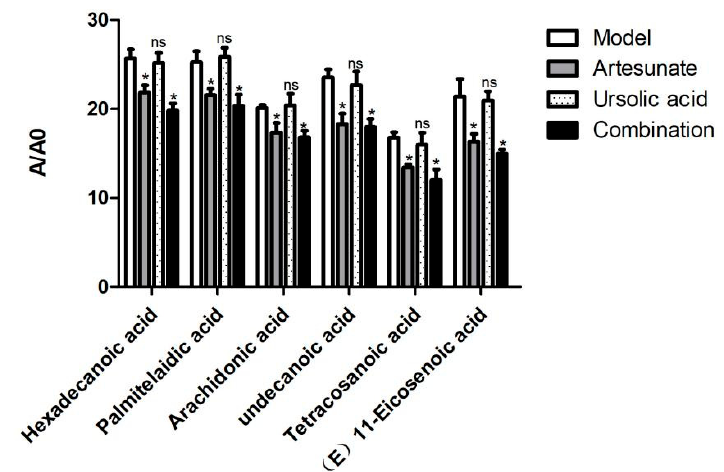
Figure 7. The relative intensity of long chain fatty acids of the model group, artesunate group, and combination group (artesunate + ursolic acid) in the serum. A / A0 is expressed by its peak area normalized against that of the internal standard. Values are represented as mean ± SD. Significant difference vs. the model group (* p < 0.05, ns means there was no significant difference between the drug treatment groups and model groups).